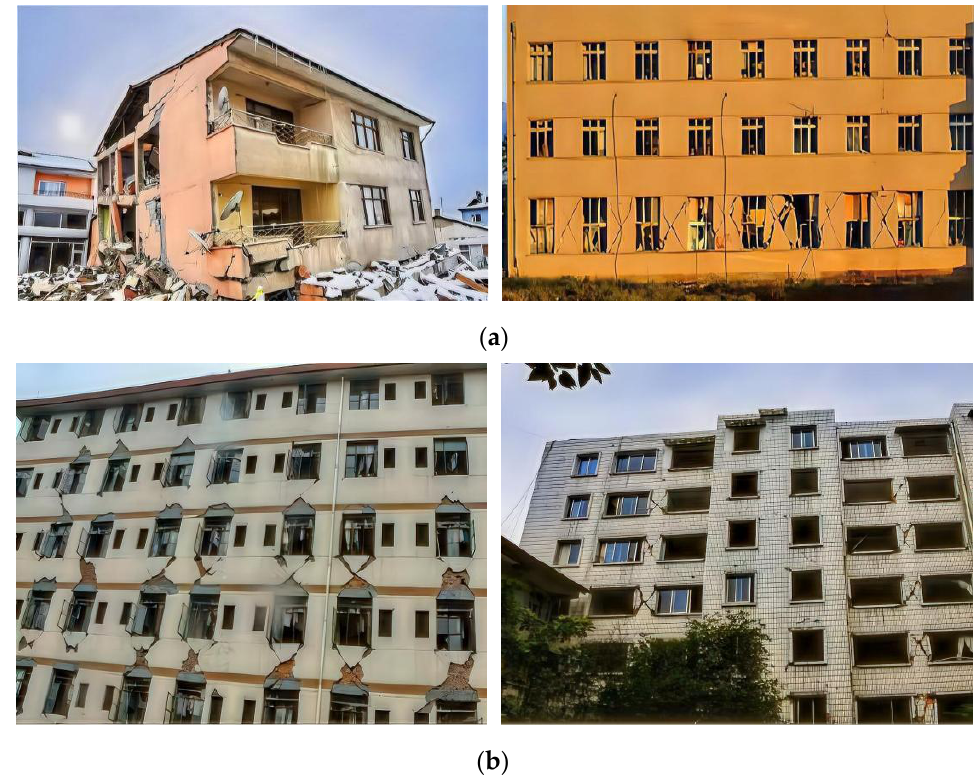
Figure 4. Typic al damaged masonry buildings in Ya’an, Sichuan, China : ( a ) masonry buildings of 2 – 3 floors; ( b ) masonry buildings of 5 – 6